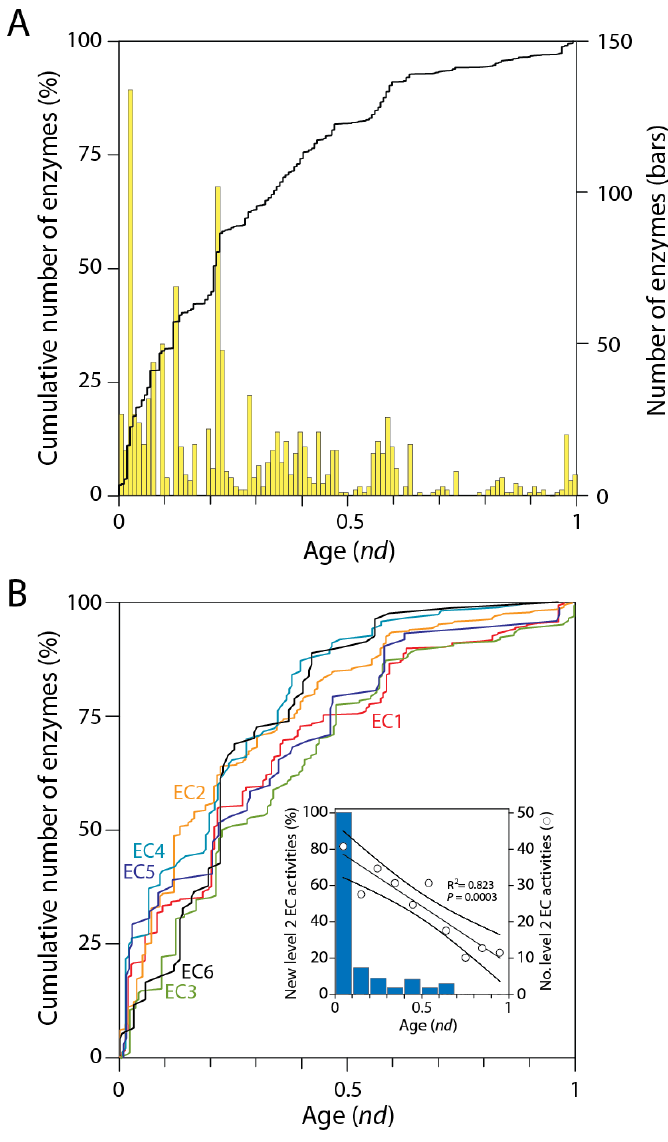
Figure 3: Timeline of enzyme evolution. A. Appearance (bar plot) and accumulation of enzymes in evolution. The age of enzymes was derived from ancestries of protein domain constituents ( nd ). These ancestries define enzyme age, with nd = 0 representing the origin of enzymes and nd = 1 the present. A molecular clock of folds shows the entire timeline spans ~3.8 billion years of evolution and that nd is linearly proportional to geological time [33]. B. Accumulation of enzymes belonging to major enzymatic classes defined by the first level of EC classification. The inset shows appearance of level 2 EC activities and percentage of those that are